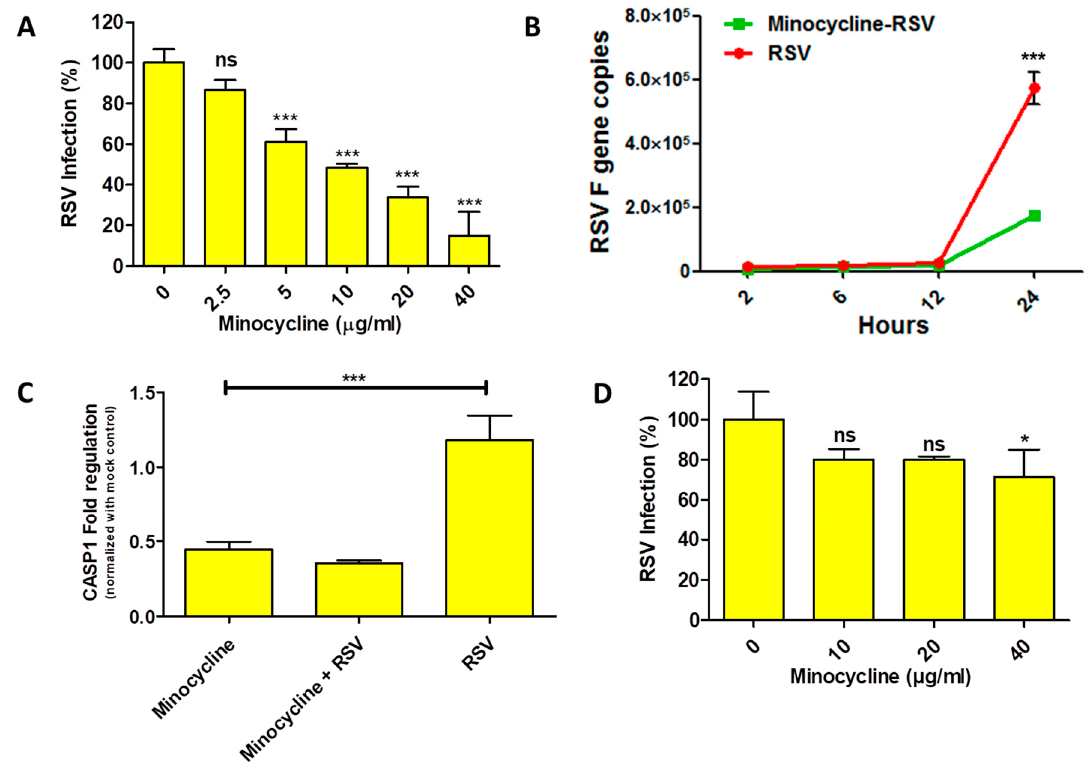
Figure 2. ( A ) Plaque reduction assay showing RSV inhibition by minocycline is represented as percentage of reduction in RSV infection; transformation derived from RSV counts (plaque forming units) (One-way ANOVA, Tukey’s multiple comparison test). ( B ) RSV F gene quantification for RSV infected cells that were minocycline treated at 10 µ g / mL (green squares) and untreated cells (red circles) (Two-way ANOVA, Bonferroni post-test). ( C ) CASP1 gene regulation (after 24 h of treatment) normalized with GAPDH for minocycline, minocycline + RSV and RSV infected cells compared to mock-treated control. ( D ) Plaque reduction assay when RSV was allowed to infect for 1 h followed by minocycline treatment, the inhibition was statistically significant at 40 µ g / mL. n = 3, values in the graphs represent mean with standard deviation (as error bar) with One-way ANOVA, Tukey’s multiple comparison test, significance level * p ≤ 0.05 or ** p ≤ 0.01 or *** p ≤ 0.0001 or ns as non-significant).